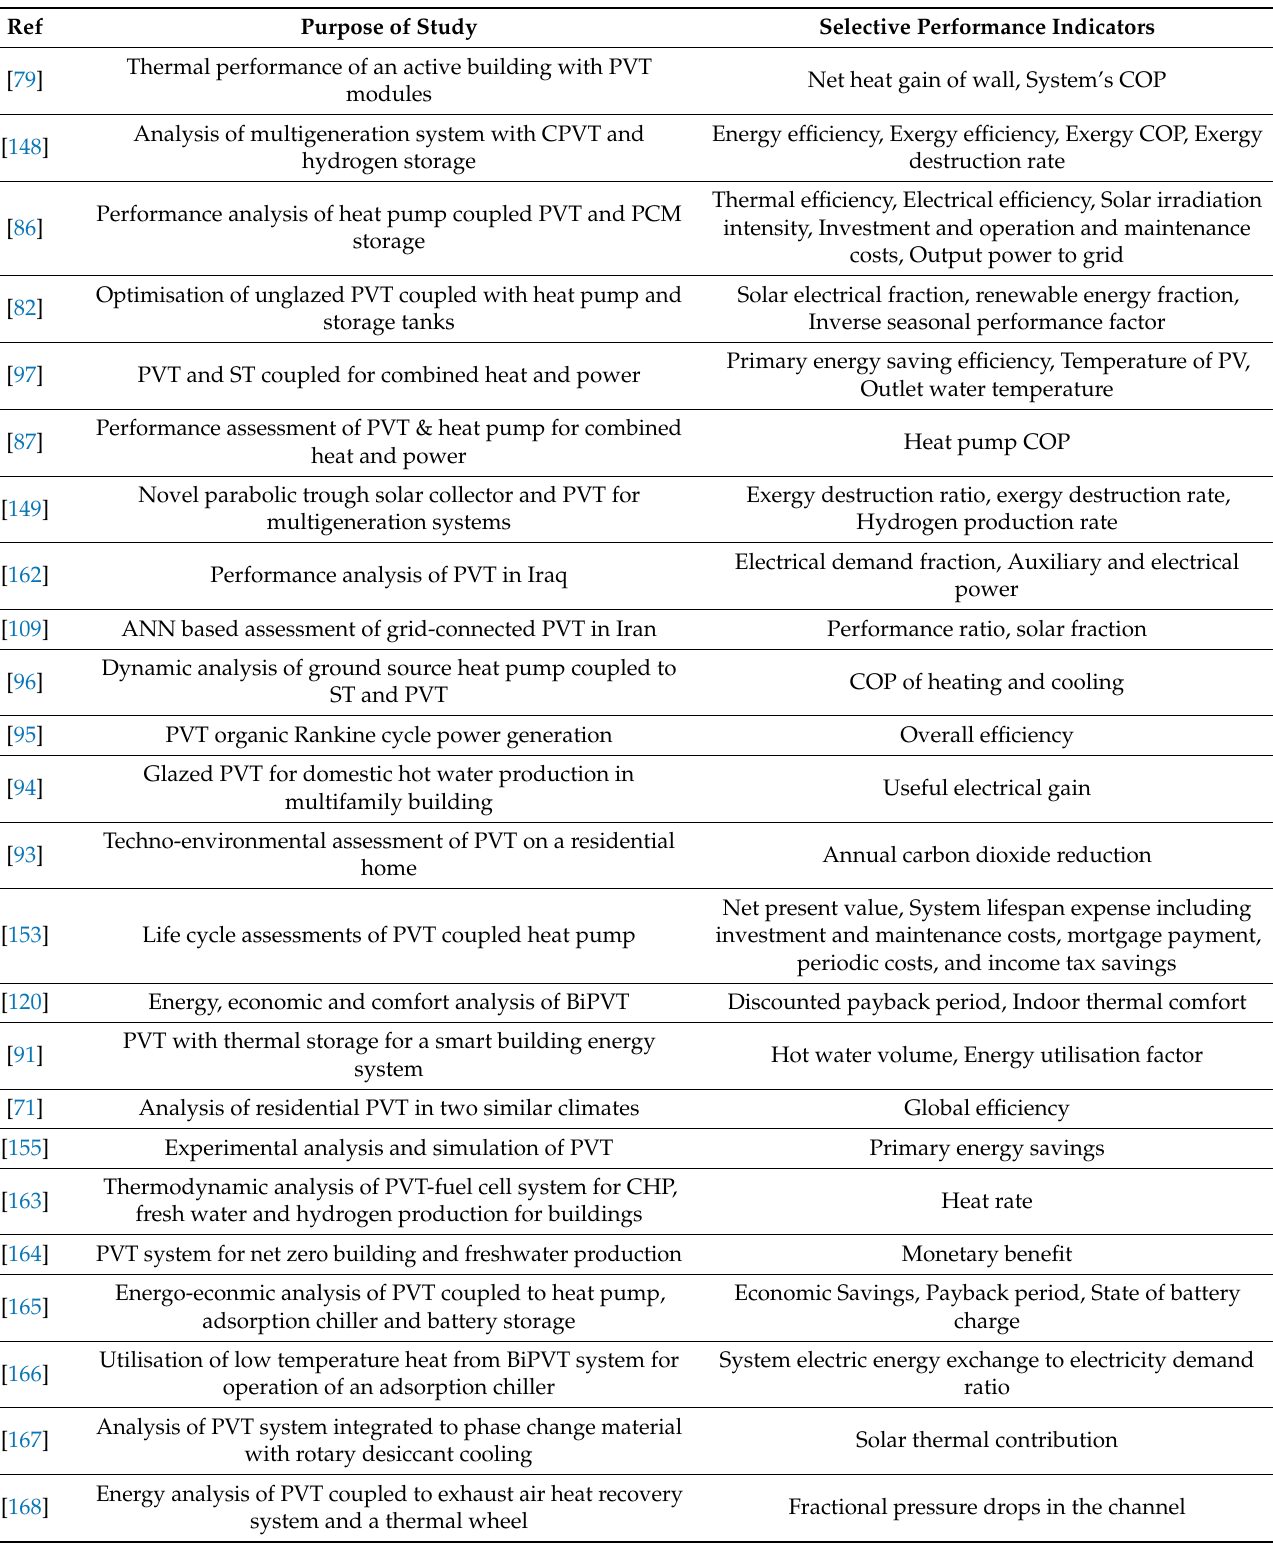
Table 3. Performance indicators of PVT